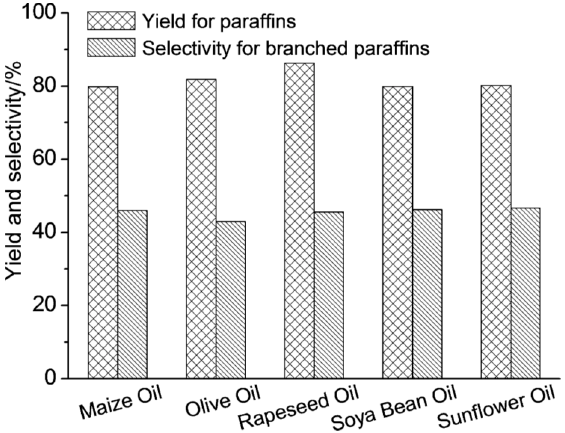
Figure 5. Yield and selectivity obtained from different vegetal oil hydrodeoxygenation. Reproduced with permission from [40]. Copyright The Royal Society of Chemistry, 2011.